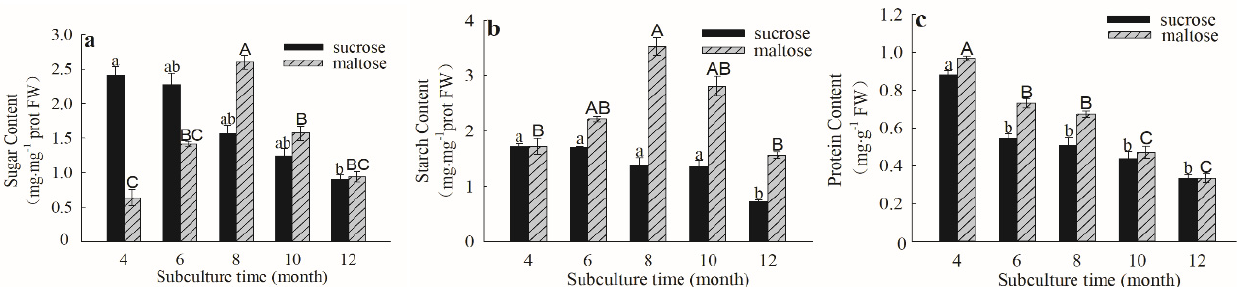
Figure 5. Effects of carbon sources on storage material contents of embryogenic callus of Pinus koraiensis during long-term subculture. ( a ) Sugar content in callus with different carbon sources, ( b ) Starch content in callus with different carbon sources, ( c ) The content of callus protein with different carbon sources; Note: Different letters (upper or lower case) in the table indicate significant differences between columns (Duncan’s multiple range test; p = 0.05).